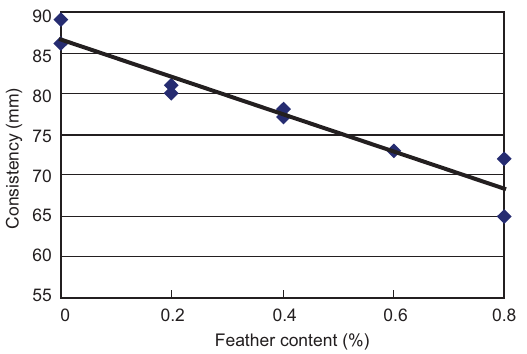
Figure 3 Consistency value of fresh mortar as a function of feather fiber